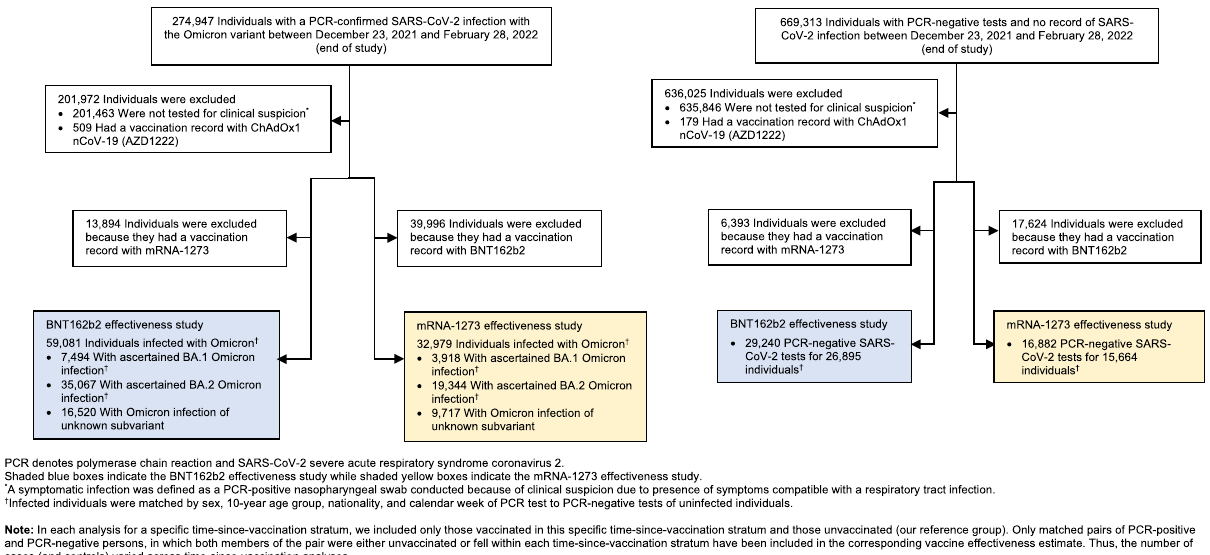
Fig. 2 Study population selection process. Flowchart describing the population selection process for investigating effectiveness of the BNT162b2 and mRNA-1273 vaccines during the SARS-CoV-2 Omicron infection